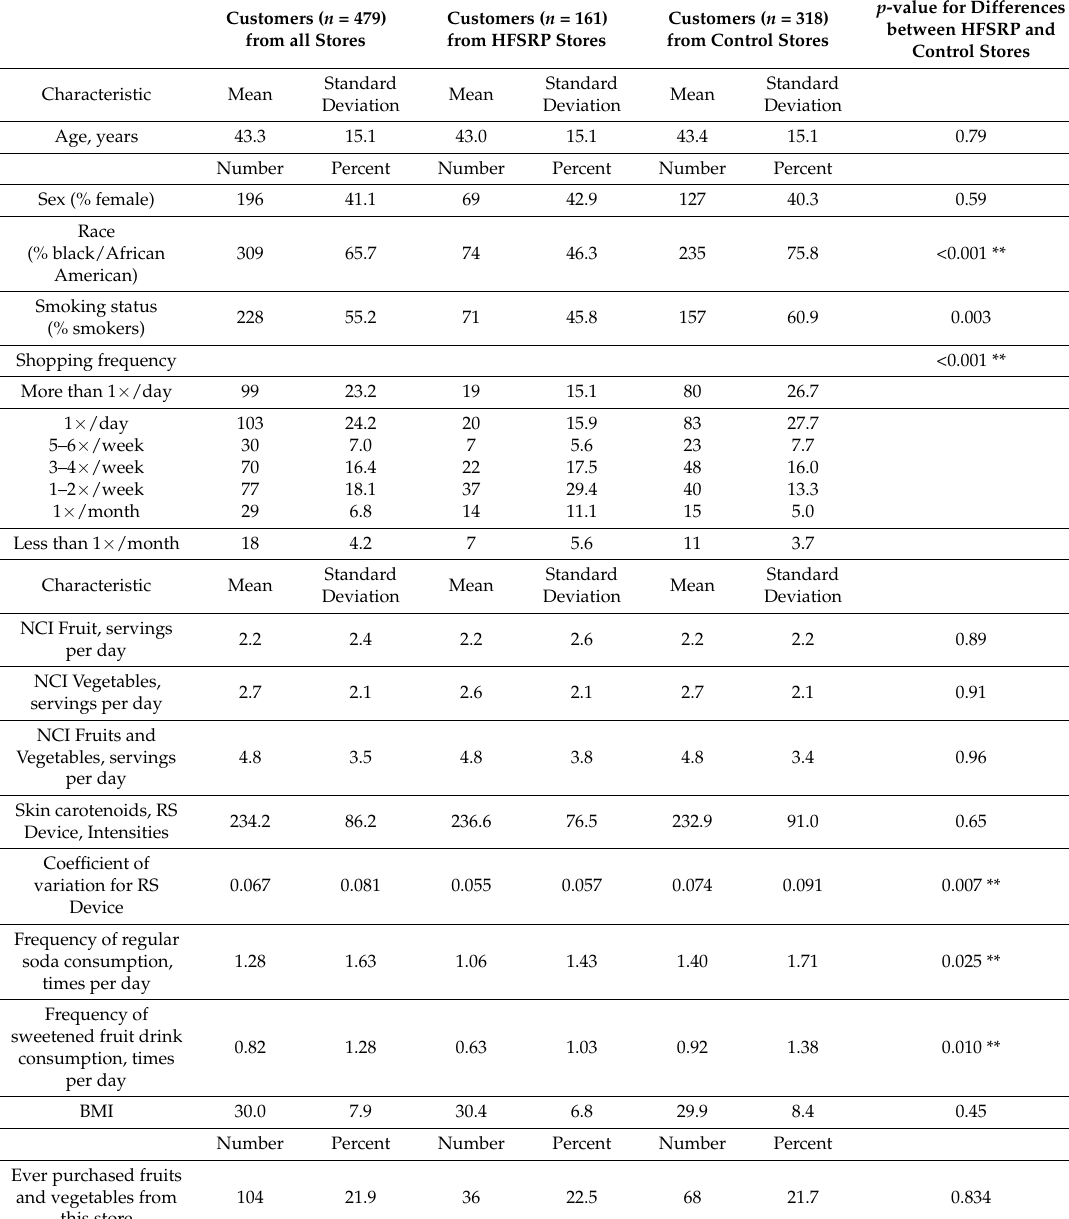
Table 2. Demographic and dietary characteristics of customers from all stores ( n = 479), and stratified by North Carolina Healthy Food Small Retailer Program stores and Control stores, and the p -value for the difference between HFSRP and Control store